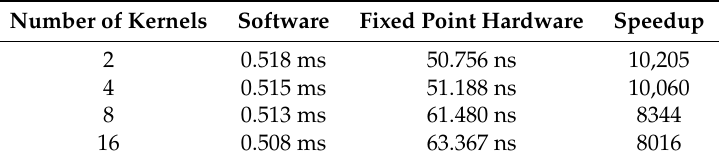
Table 5. Execution time, t s , of the XOR gate dataset—fixed point.